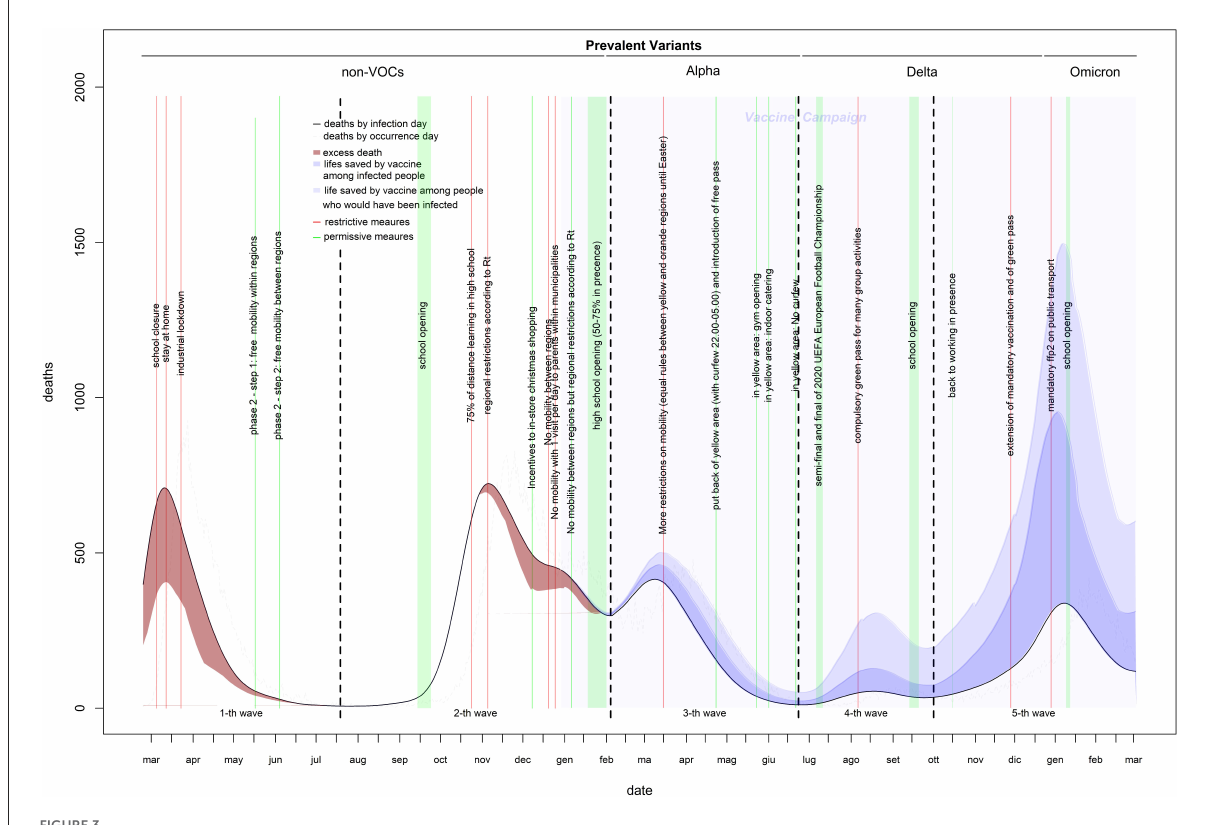
FIGURE3 Daily deaths of COVID-19 in Italy (February